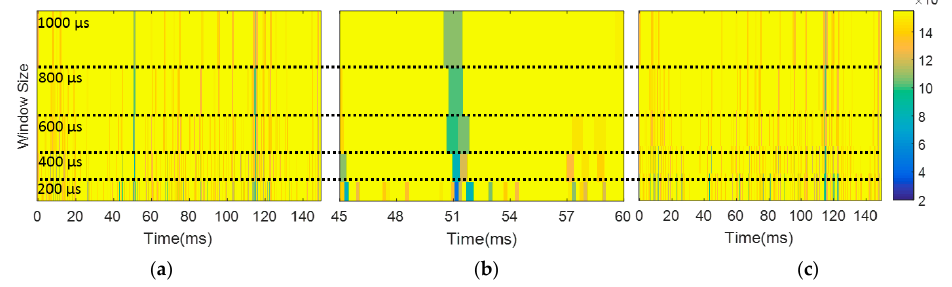
Figure 13. The spectra of AE power (unit: V*s 2 ), ( a ) embedded streamed signal ( SNR = 1.0), ( b ) windowed embedded stream signal to 45–60 ms, and ( c ) original streamed signal.